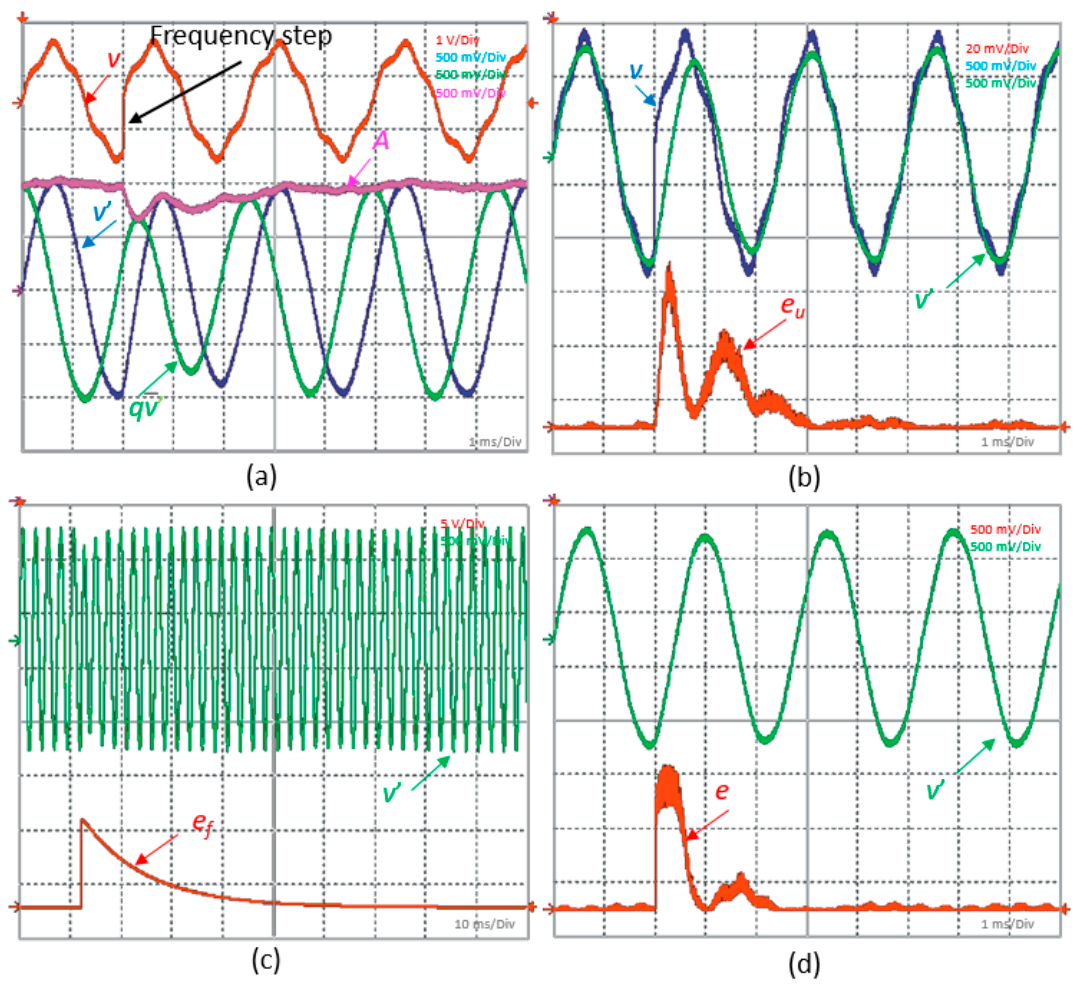
Figure 11. Dynamic performance of the proposed algorithm for grid frequency step of 1%: ( a ) waveforms of the input signal ( v ), estimated quadrature signals ( v ’ and qv ’) and estimated amplitude of input signal ( A ); ( b ) waveforms of the input signal ( v ), estimated sine signal ( v ’) and amplitude estimation error ( e A ); ( c ) waveforms of the estimated sine signal ( v ’) and frequency estimation error ( e f ); ( d ) waveforms of the estimated sine signal ( v ’) and instantaneous estimation error ( e ).